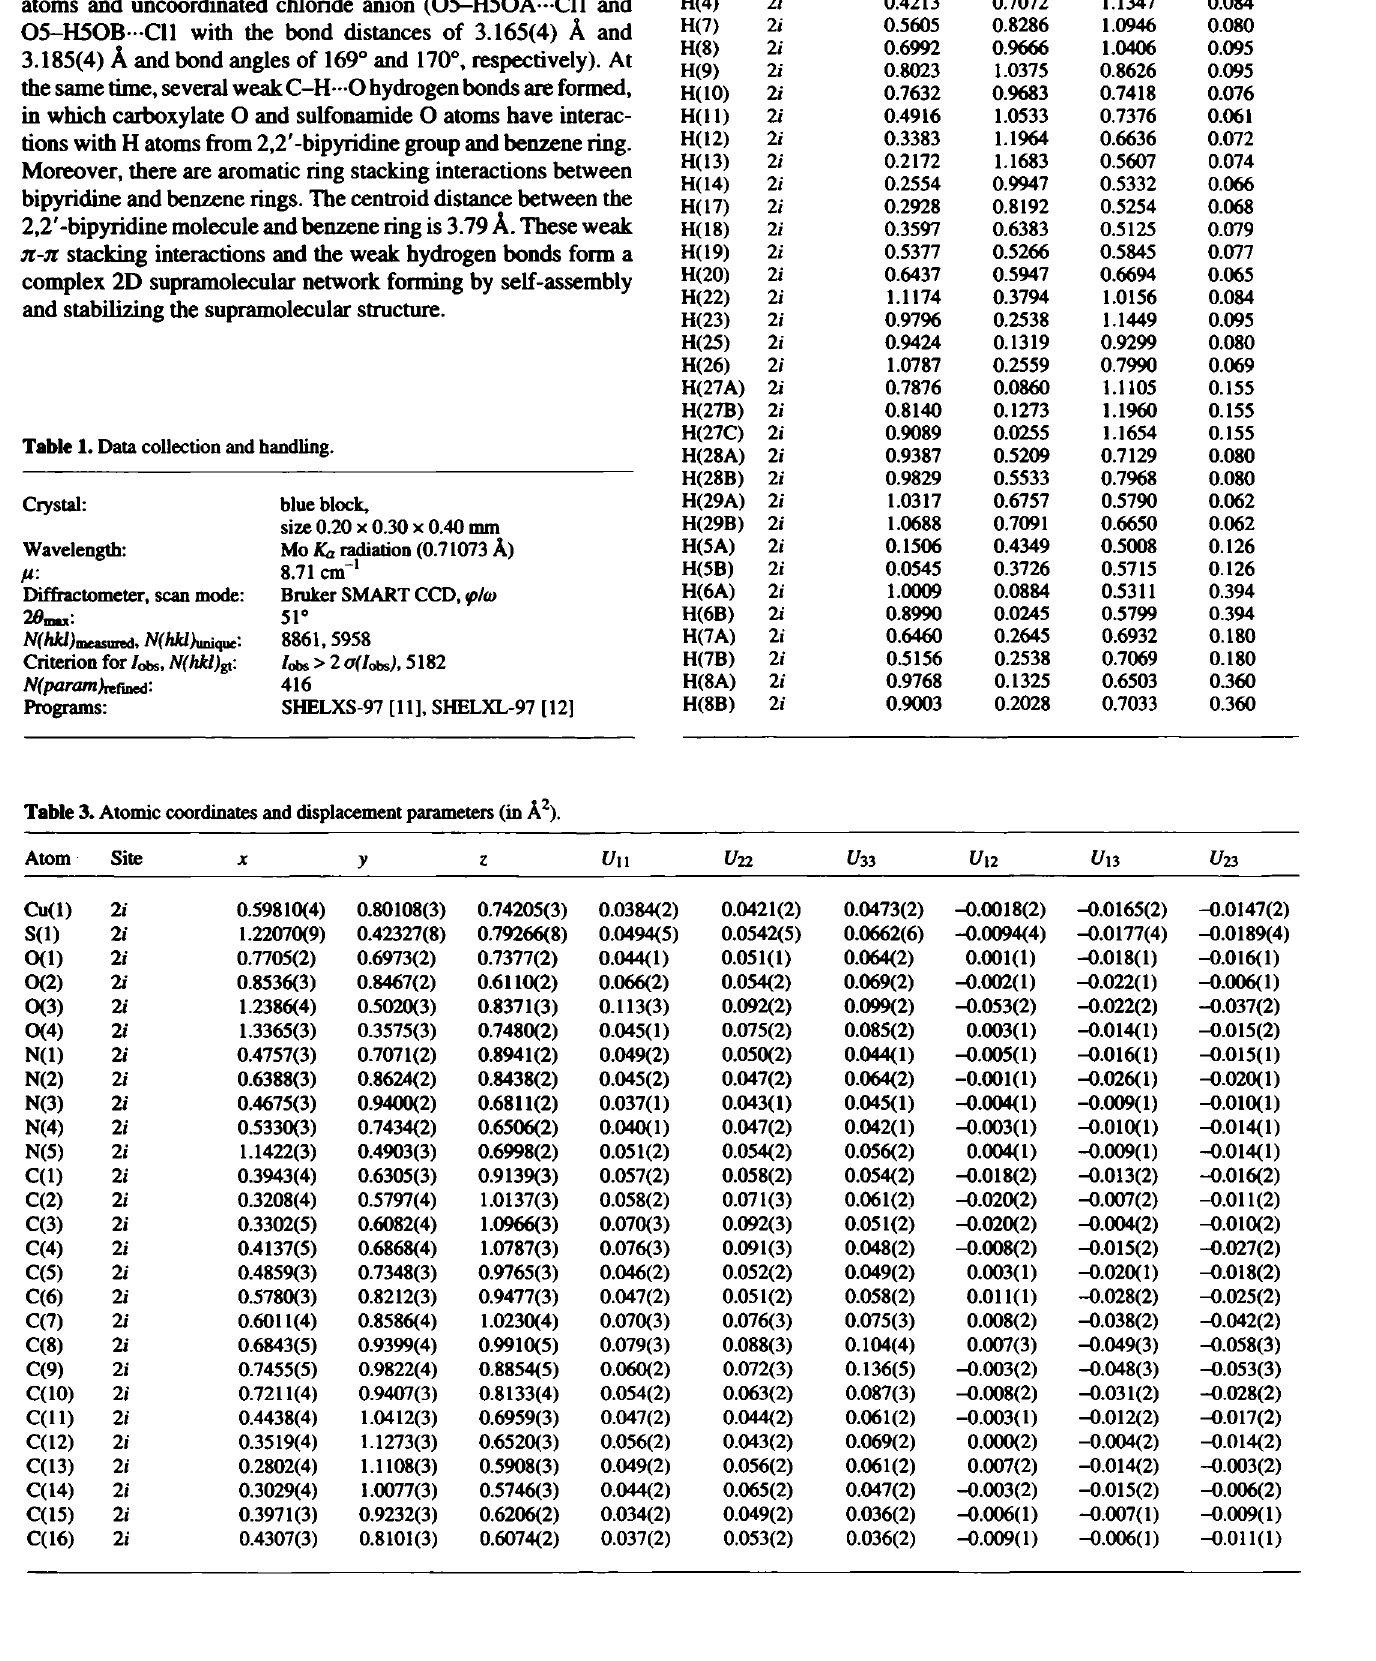
Table 1. Data collection and handling.